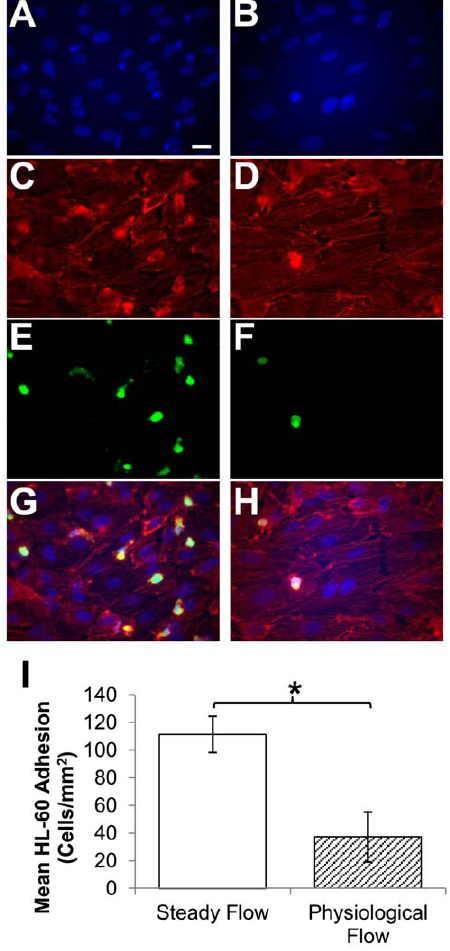
Figure 8. HL-60 cell adhesion to flow-conditioned endothelial cells. Endothelial cell monolayers were grown to confluence and cultured under steady flow (A,C,E,G) or physiological flow (B,D,F,H) for 24 hours. During the last four hours, endothelial cells were activated with 1 U TNF-a to stimulate adhesion molecule expression. At hour 24, monolayers were removed from flow chambers and incubated for 10 minutes with a bolus of GFP + HL-60 cells (1000 cells/mm 2 ) and stained as described (A,B: DAPI; C,D: F-actin; E,F: GFP + HL-60 cells; G,H: overlay). Shown are representative images (40x) from each condition. Scale bar: 20 microns. (I): HL-60 cell adhesion in 15 predetermined locations per monolayer was quantified. Results are displayed as mean 6 SEM (n=5– 6). Asterisk denotes significant difference in means between groups as determined by Student’s t-test.